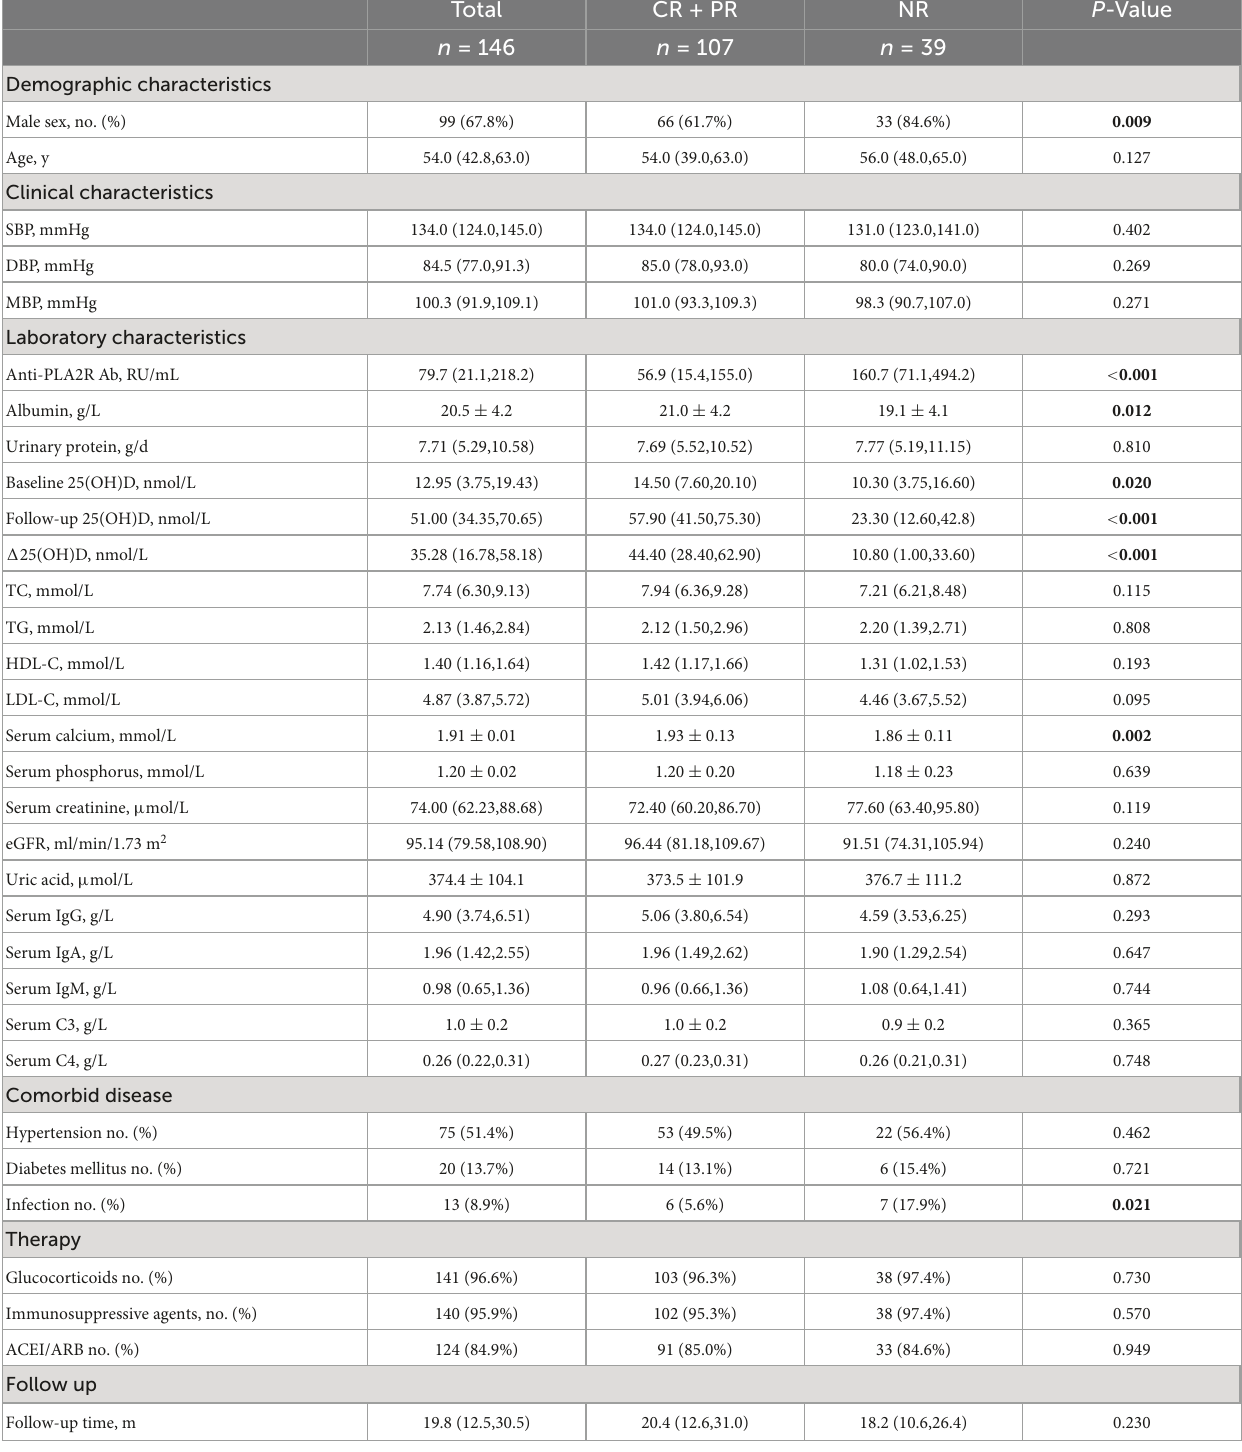
TABLE 4 Characteristics of patients with nephrotic syndrome according to different outcomes. Total CR + PR NR P